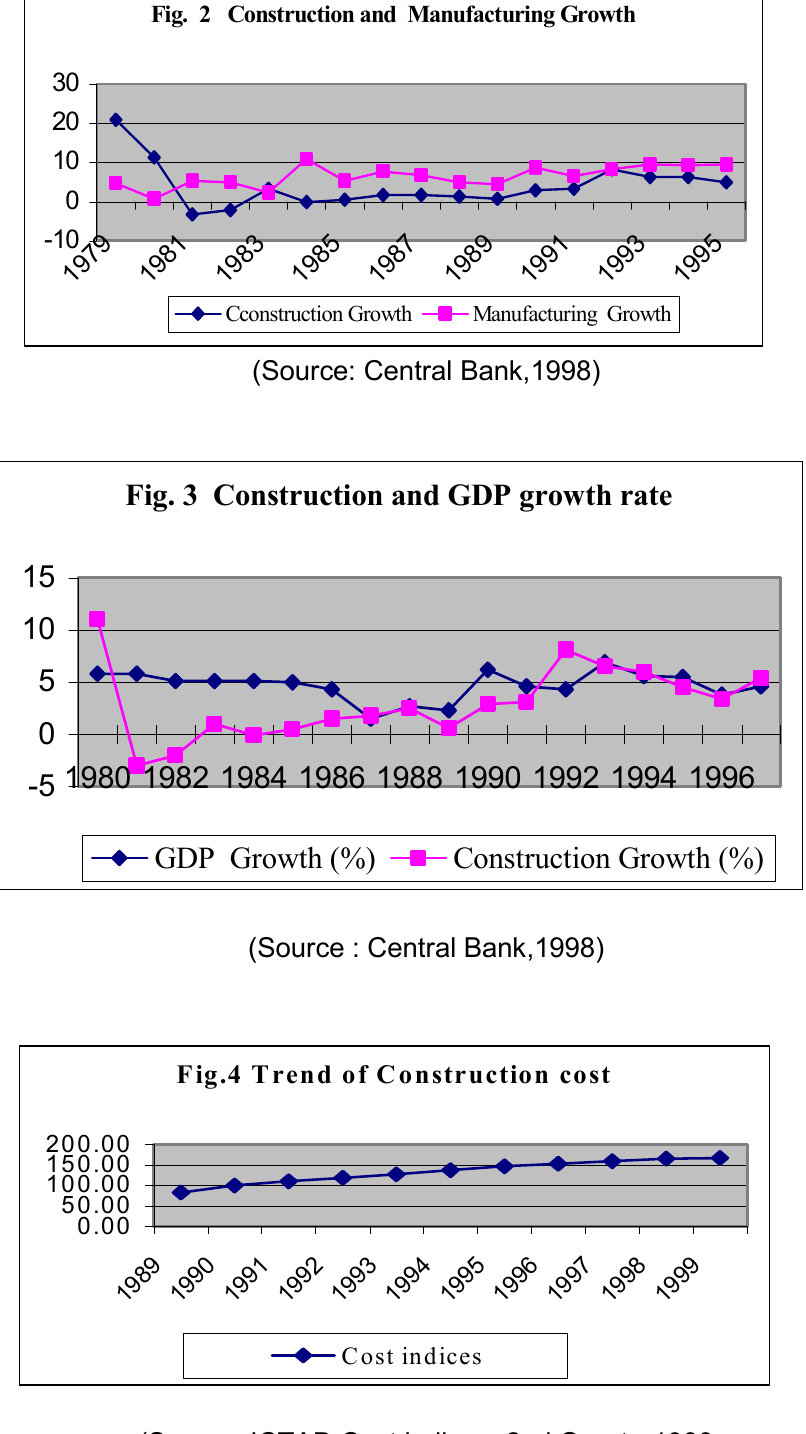
Fig. 2 Construction and Manufacturing Growth